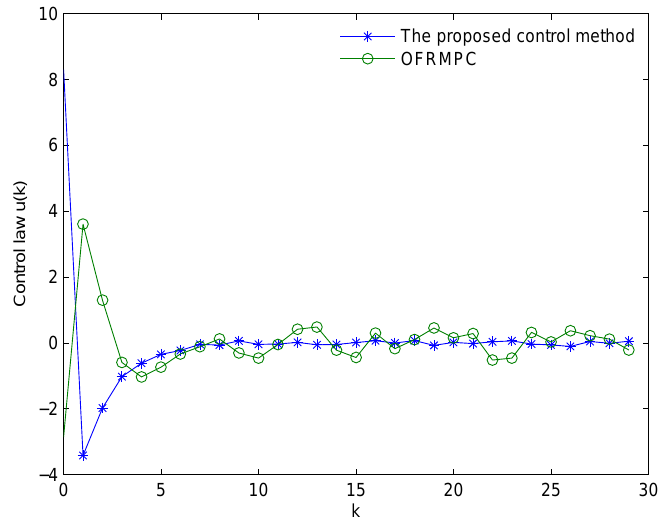
Figure 6. The control law for the proposed method and OFRMPC